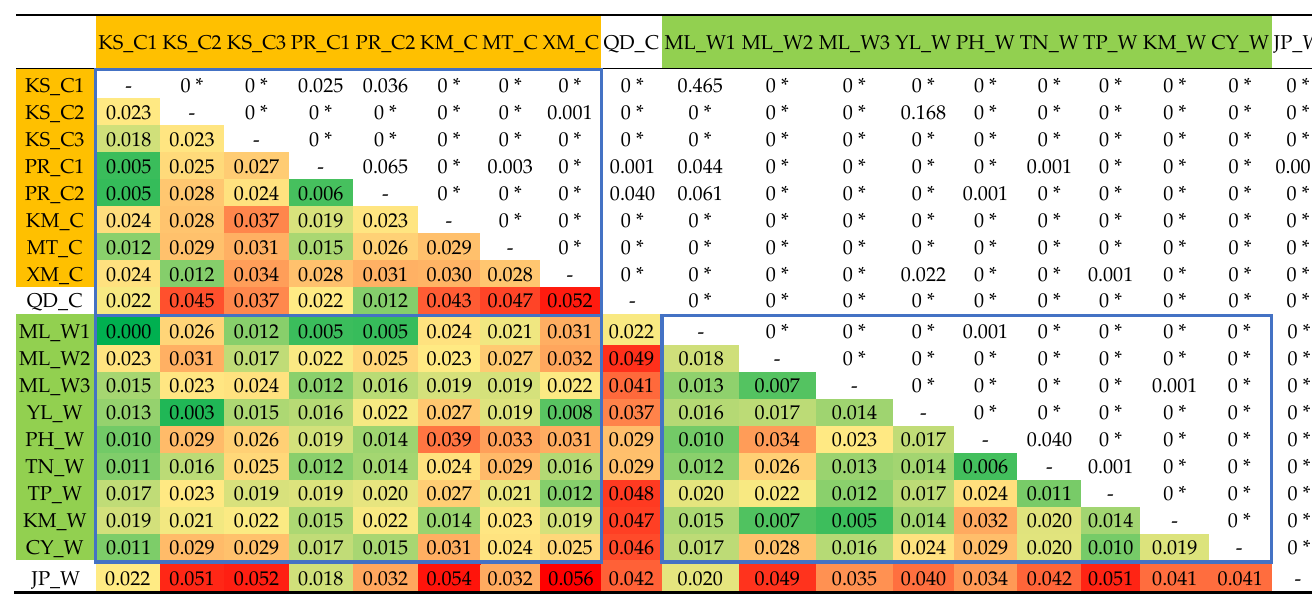
Table 6. Pairwise F ST values (below the diagonal) and associated p values (above the diagonal) among 19 black sea bream populations collected from Taiwanese hatcheries and the wild.